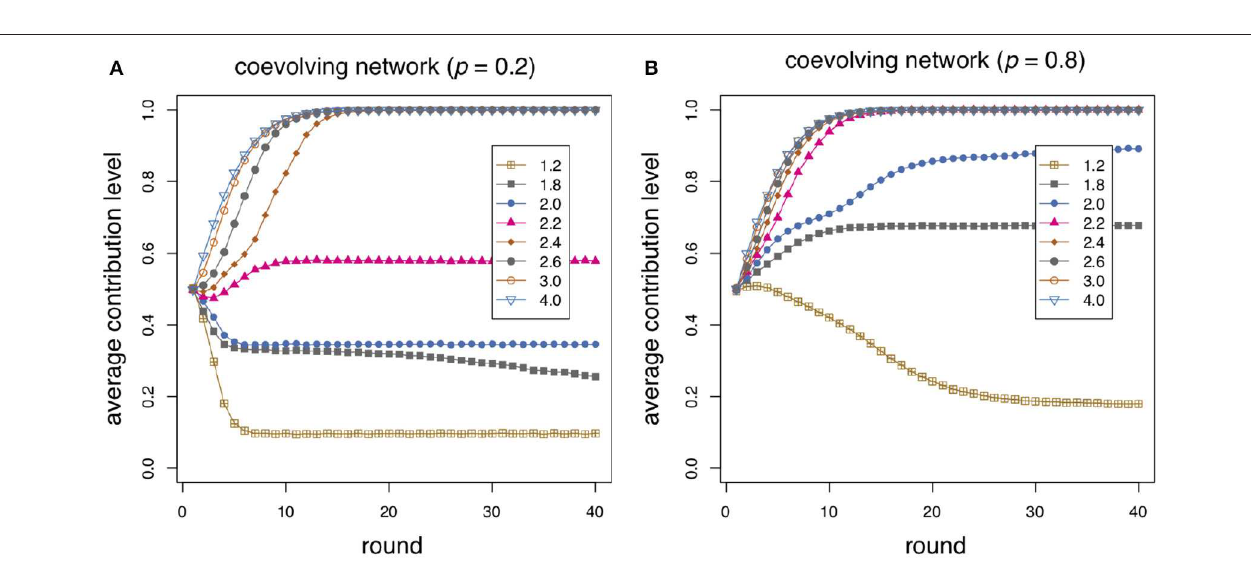
FIGURE 2 | Average individual contribution as a function of round number for several values of the enhancement factor r as shown in the inset. The average is taken over 40 independent repetitions of 40 rounds on a network of size 500 and α = 0.3. (A) Static case, i.e., the network topology doesn’t change during the simulation. (B) Coevolving network case, i.e., unsatisfied players may redirect a link to a random group with probability p = 0.5.